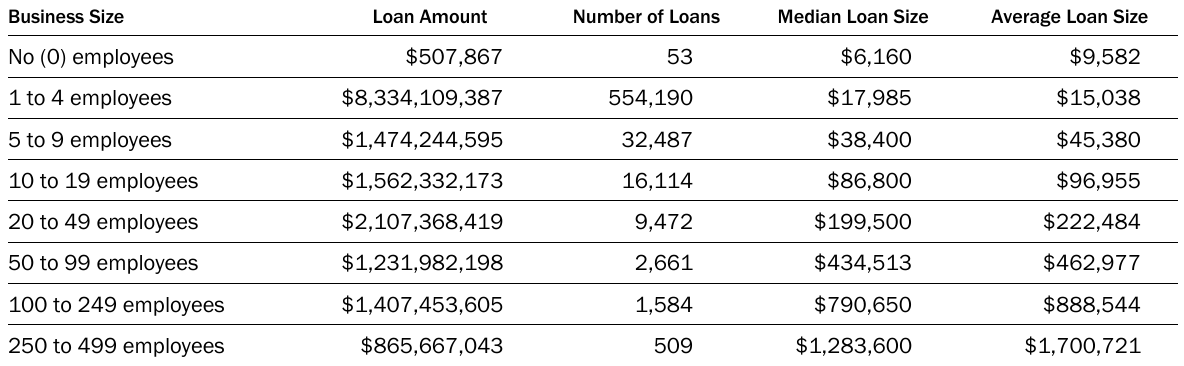
Table A1. Paycheck Protection Program (PPP) Loan Recipients in Agriculture by Business Size